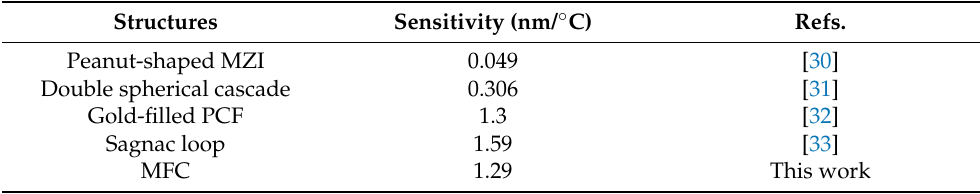
Figure 15. Temperature dependence curve of refractive index of isopropanol. Table 1. The sensitivity of temperature sensors of different structures.